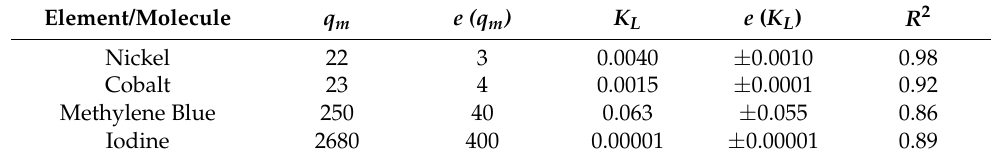
Table 3. Nonlinear fitting parameters between q e and C e found using Langmuir adsorption model.